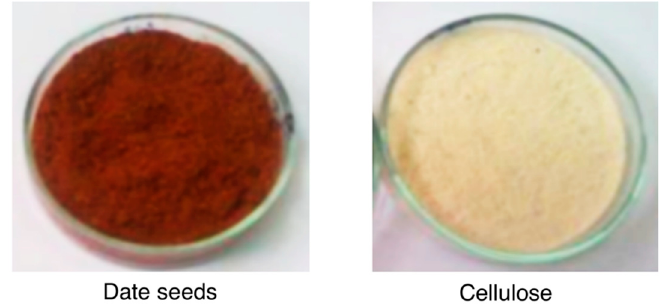
Figure 3. Photos of cellulose extracted from date seed powders.